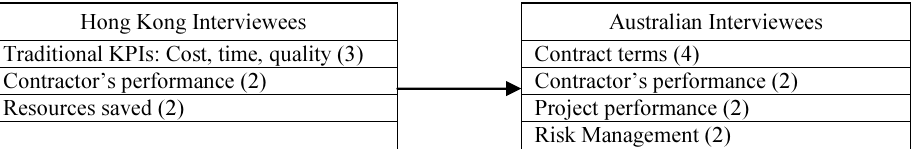
Table 9. Question 4 – What do you feel are the key performance indicators in a PPP project?